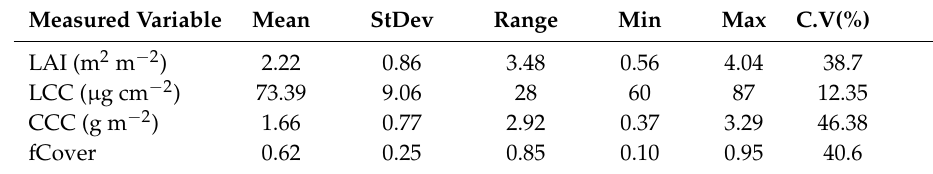
Table 2. The summary statistics of measured variables over 27 plots of potato crop. Measured Variable